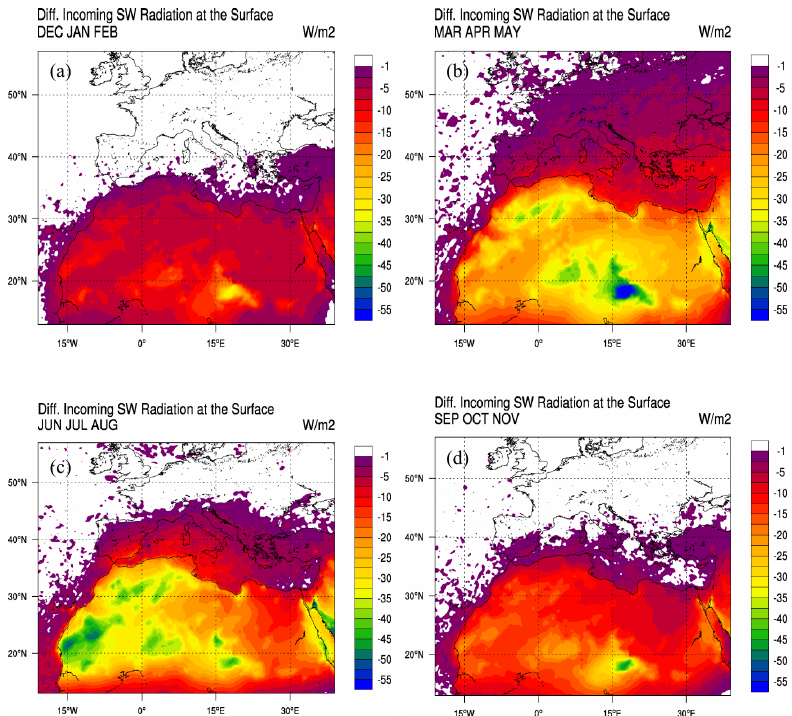
Fig. 9. Spatial difference between the model simulations (WDE – NDE) in the incoming shortwave radiation at the surface, as averaged during the winter (a) , spring (b) , summer (c) and autumn (d) seasons of the 6-year period.